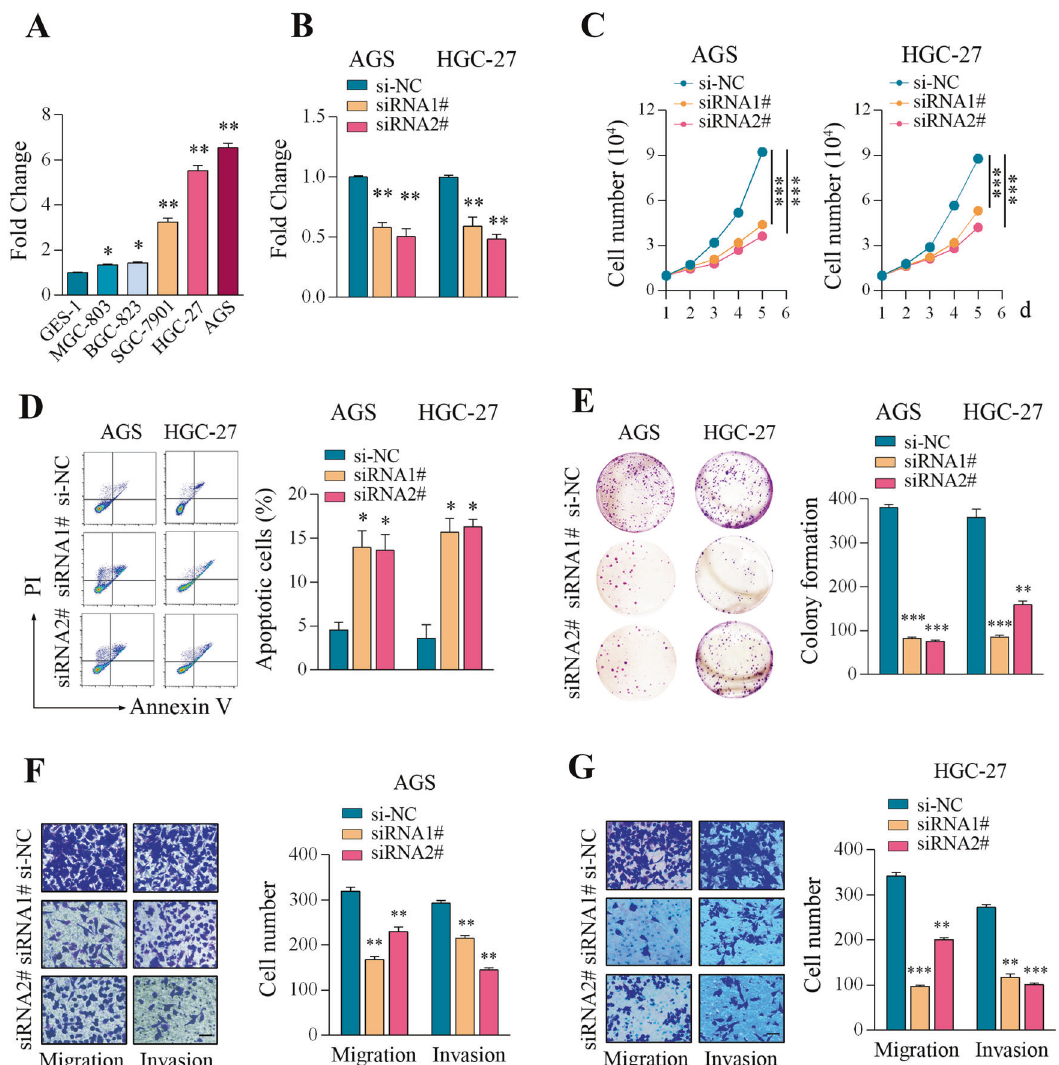
Fig. 2 Knockdown of DLGAP1-AS2 suppressed proliferation, migration, and invasion of GC cells. A DLGAP1-AS2 expression was measured in a normal gastric epithelial cell line (GES-1) and established GC cell lines (MGC ‐ 803, BGC ‐ 823, SGC ‐ 7901, AGS, and HGC ‐ 27) using RT-qPCR. B qPCR veri fi cation of the knockdown ef fi ciency of DLGAP1-AS2 by using two independent siRNA oligonucleotides siRNA 1# and siRNA 2# in the treatment of AGS and HGC-27 cells. C Cell counting assays upon DLGAP1-AS2 knockdown in GC cells. D Apoptotic assays upon DLGAP1-AS2 knockdown in GC cells. E Colony formation assays upon DLGAP1-AS2 knockdown in GC cells. F , G Migration and invasion assays upon DLGAP1-AS2 knockdown. The data shown are representative of three independent experiments. Scale bar: 20 μ m. * P < 0.05, ** P < 0.01, *** P <